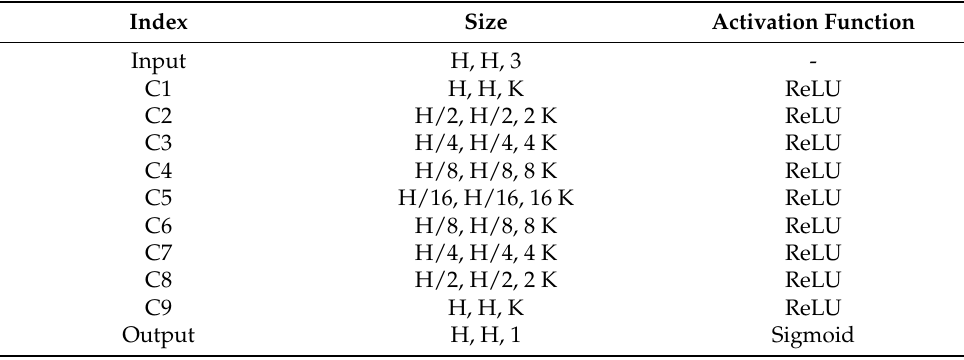
Figure 6. Schematic diagram of the structure of convolution neural network. This network consists of the input, nine convolution cells (from C1 to C9), and the output. Each rectangle represents a set of feature maps. The height of the rectangle stands for the size of feature maps. The width stands for the number of channels. The input is a RGB image, having three channels. The output is an image of probability, only having one channel. C1, C2, . . . and C9 are complex convolution cells, each containing two convolution layers, and the sizes of convolution kernels are all 3 × 3. The number of convolution kernels depends on the channels of feature maps. The blue arrows represent the pooling layers, of which the sizes are all 2 × 2, and the number of channels remains the same after the pooling process. The green arrows represent the up-sampling layers, using the interpolation algorithm to double the size of feature maps. The grey arrows represent the copying and merging process, which reduces the loss of original information caused by up-sampling. The activation functions are all Rectified Linear Units (ReLUs), except the last layer, of which the activation function is the sigmoid function. The size of the input image is marked as H × H, where H should be greater than 48 and divided by 16. The number of channels in C1 is K, and the remaining parameters are as shown in Table 1. Table 1. Feature map dimensions of convolutional neural networks.